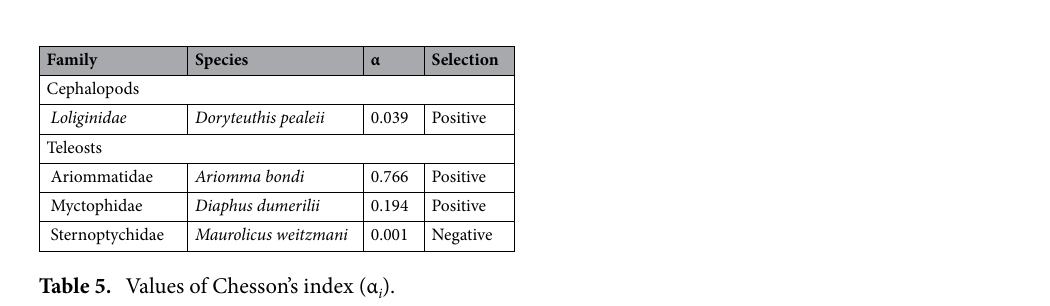
Table 5. Values of Chesson’s index (α i